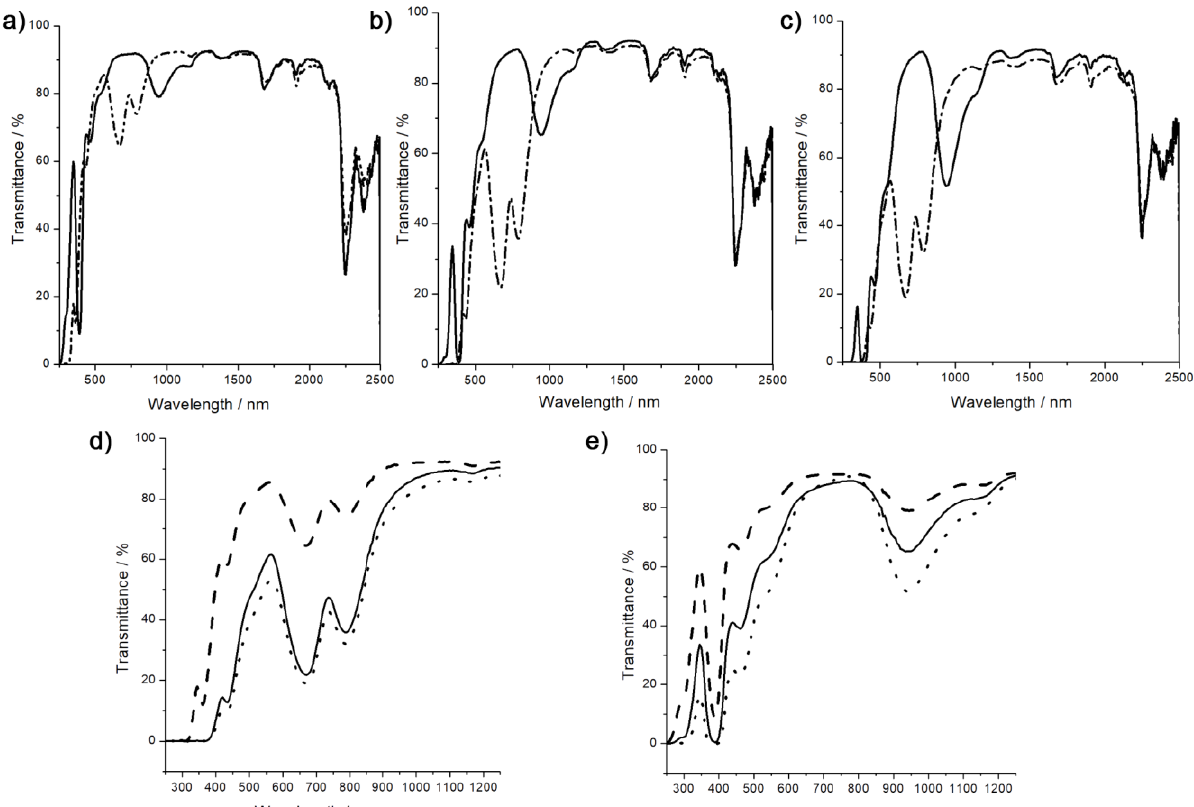
Figure 4. UV-vis-NIR spectra of Ta_x@PMMA nanocomposites in the oxidized and reduced forms. ( a ) Ta_1@PMMA brown (solid) and Ta_1@PMMA green (dash-dot), ( b ) Ta_2@PMMA brown (solid) and Ta_2@PMMA green (dash-dot), ( c ) Ta_3@PMMA brown (solid) and Ta_3@PMMA green (dash-dot), ( c ) and comparison of Ta_x@PMMA films in (d) green films at 1 wt% (dash), 2 wt% (solid) and 3 wt% (dot) and ( e ) brown films at 1 wt% (dash), 2 wt% (solid) and 3 wt% (dot). Table 2. Thermal behavior of films by DSC and FOM values of Ta 6 @PMMA nanocomposites.